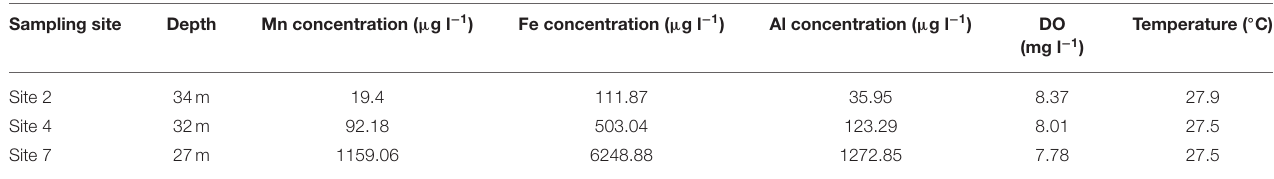
TABLE 2 | Total Mn, Fe, and Al concentrations in water samples collected at maximum depth, at sites in the Blyderiver dam located further away from the dam wall in February 2017. Sampling